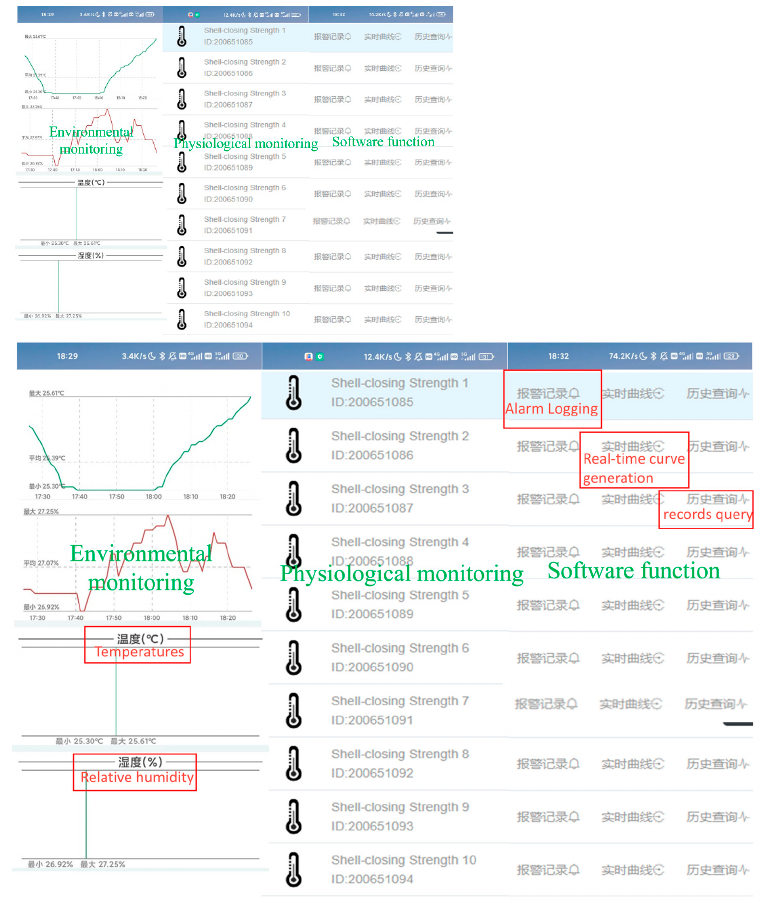
Figure 5. Software system monitoring interface display.